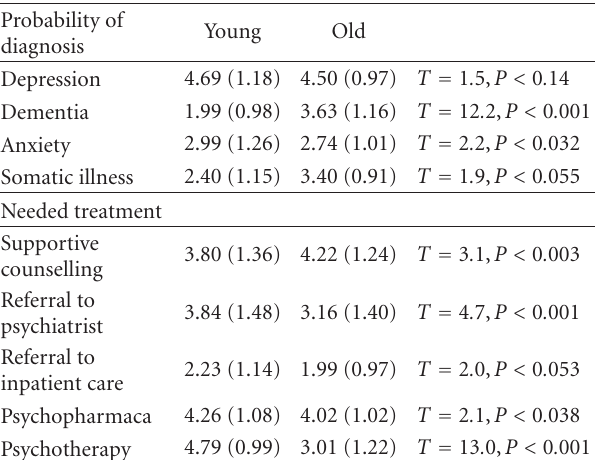
Table 1: Ratings of physicians, means (SD), on the probability (1 = very unlikely, 6 = very likely) of this diagnosis and the need for treatment (1 = very unlikely, 6 = very